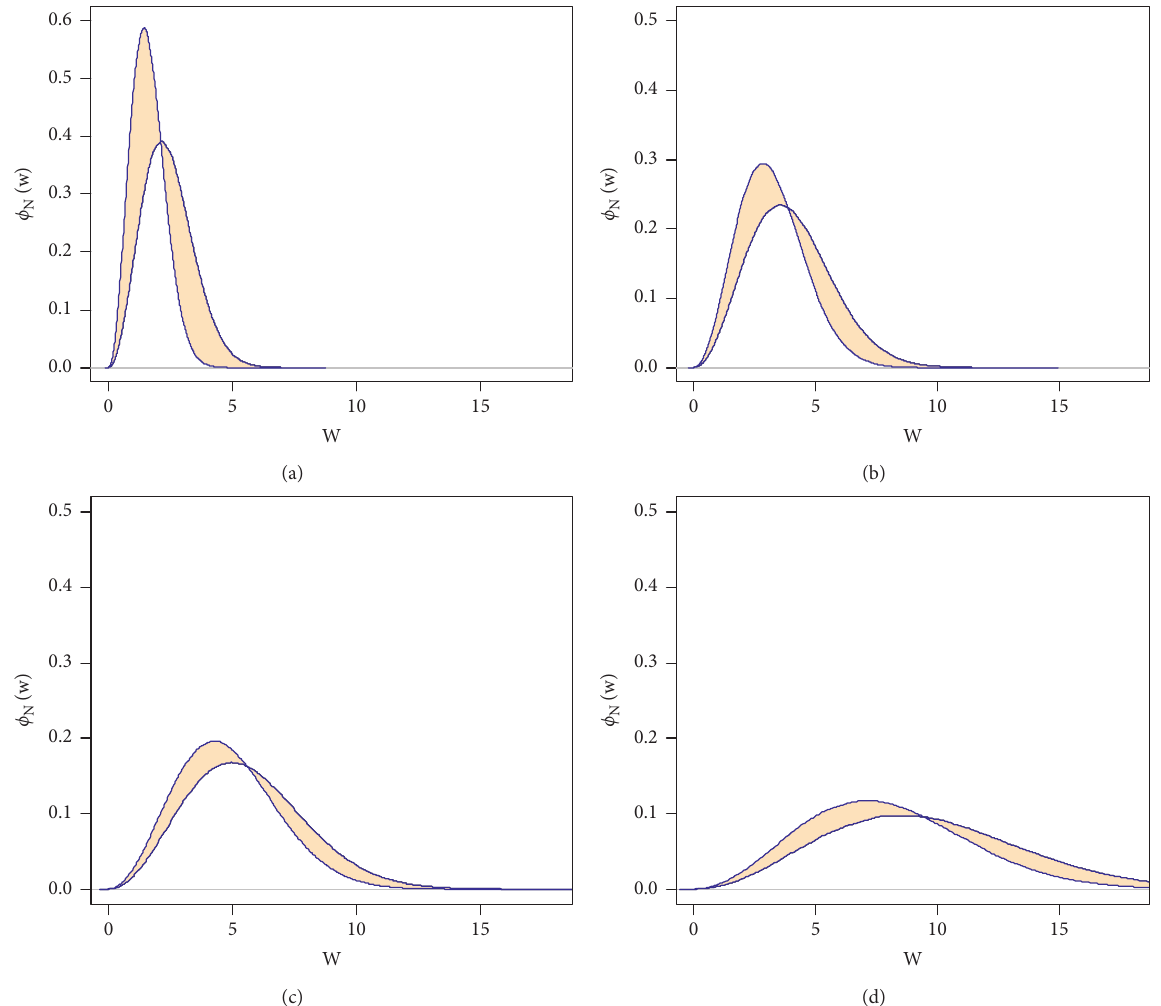
� ( 1 , 1 . 5 ) . (b) λ � ( 2 , 2 . 5 ) . (c) λ � ( 3 , 3 . 5 ) , N N N